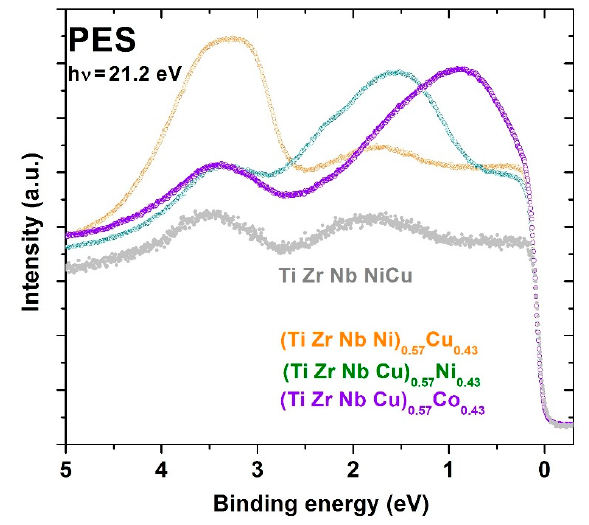
Figure 12. Photoemission spectra of TiZrNbCuNi MG and (TiZrNbNi) 1 − x Cu x , (TiZrNbCu) 1 − x Ni x and (TiZrNbNi) 1 − x Co x MGs with x = 0.43. Large peaks in alloys with x = 0.43 correspond to the 3d states of Cu, Ni and Co.